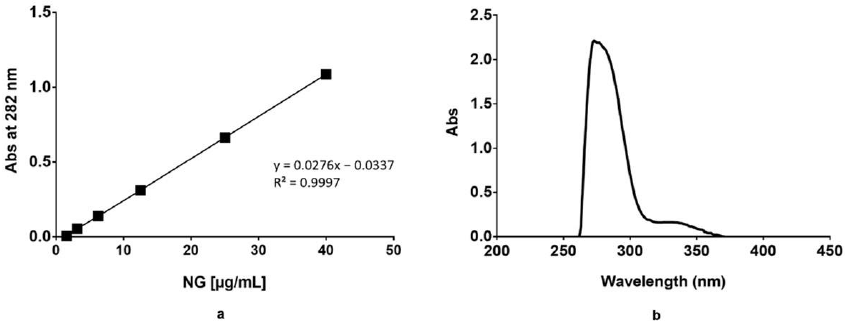
Figure 2. Calibration curve of Naringin solutions at different concentrations (3.125–40 µ g/mL) measured at 282 nm ( a ), UV–Vis spectrum of NG standard solution in PBS 1X pH 7.4 (12.5 µ g/mL) ( b ). Standard deviations are not noticeable as <0.01, plot a.